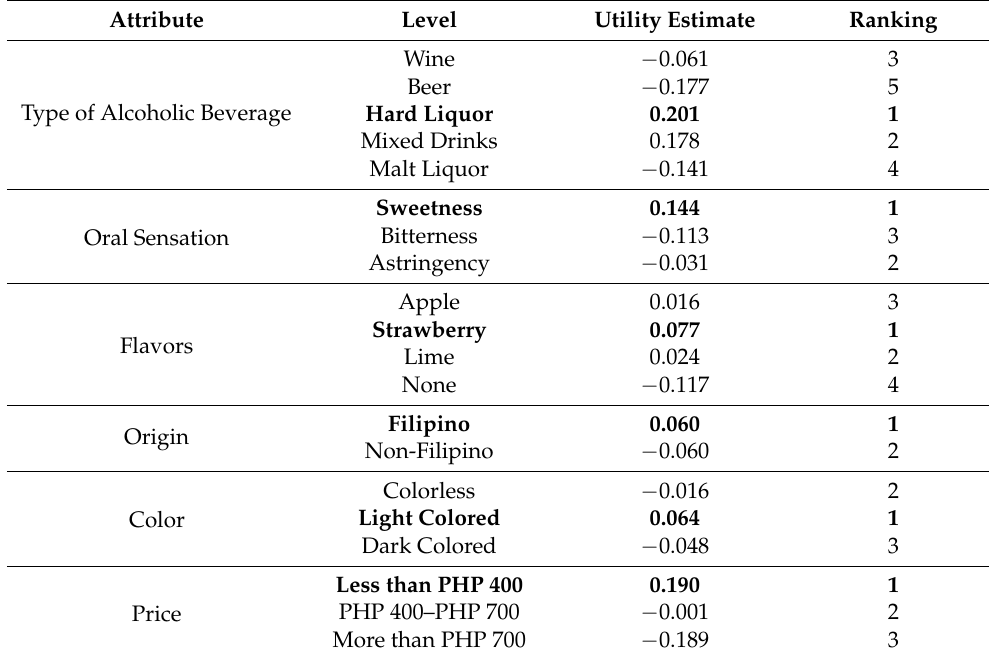
Table 6. Summary of Utility